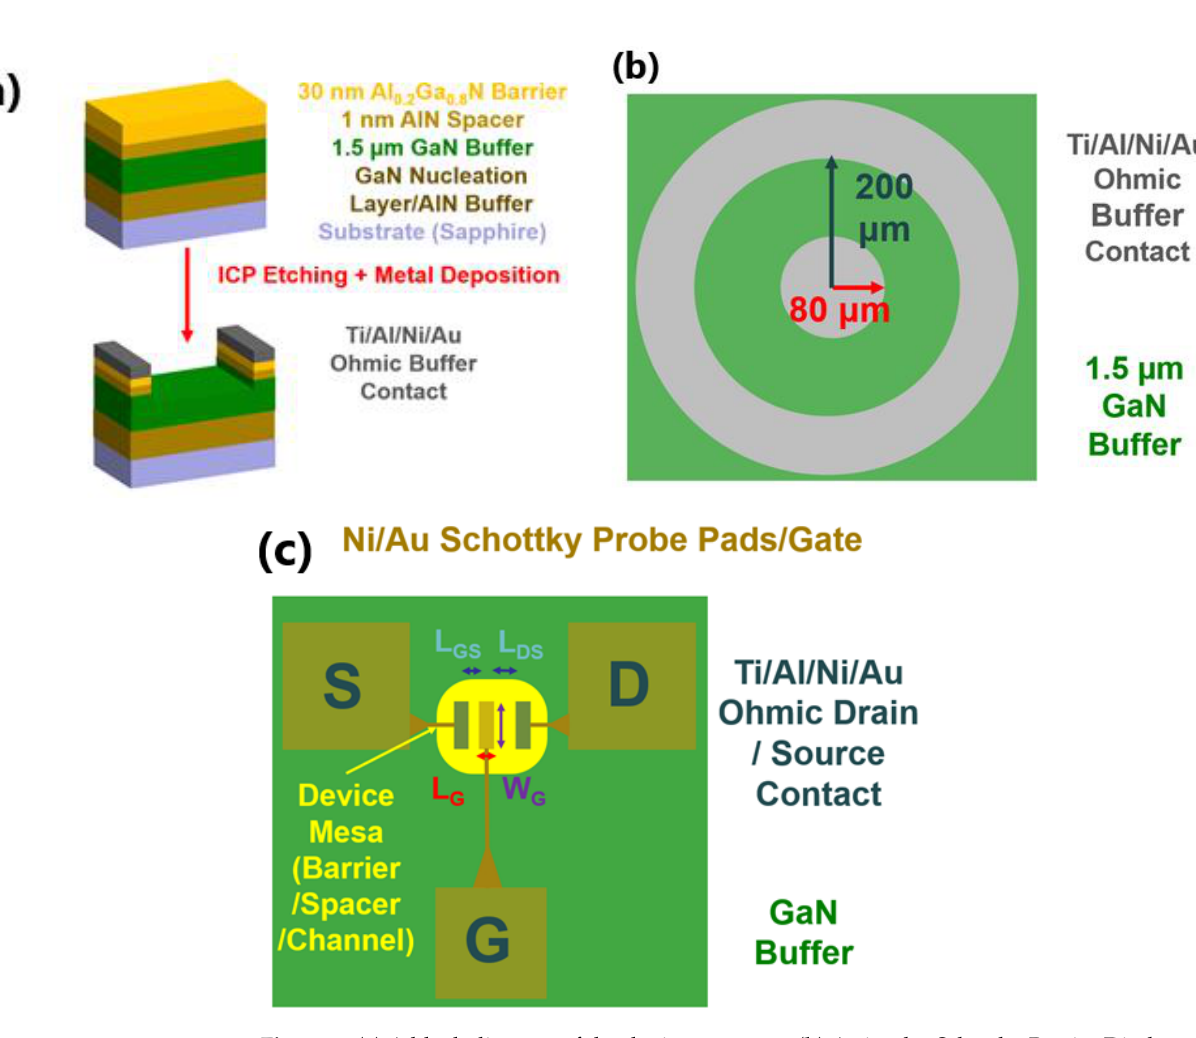
Table 1. The growth parameters of the four samples.